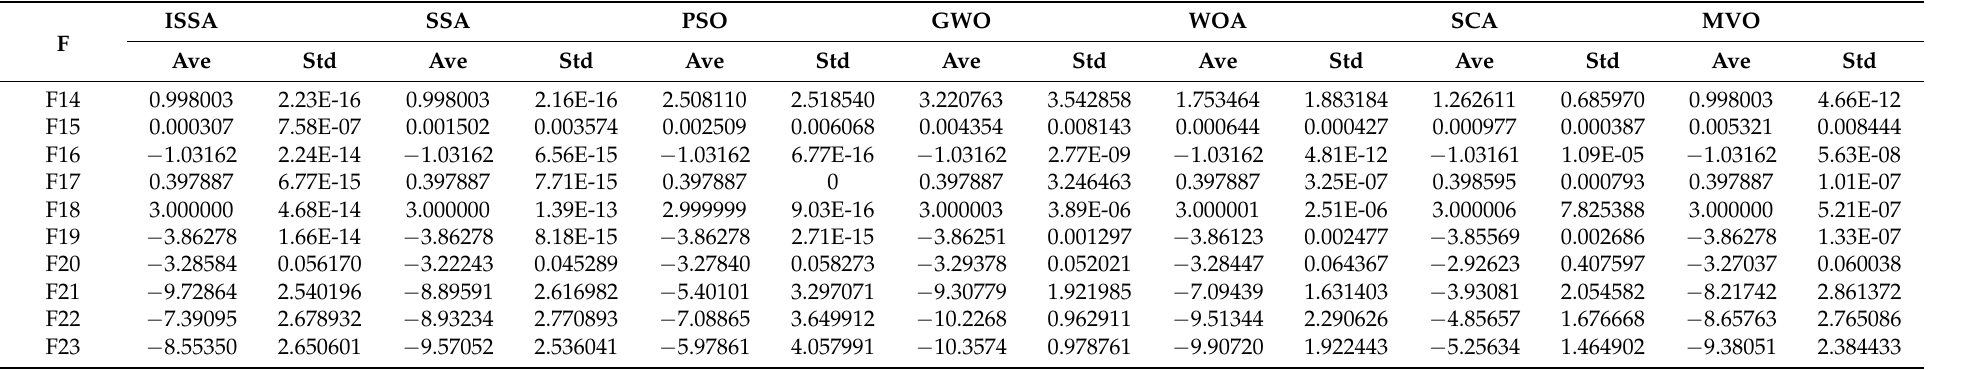
Table 6. Statistical results of ISSA on fixed-dimension multimodal benchmark